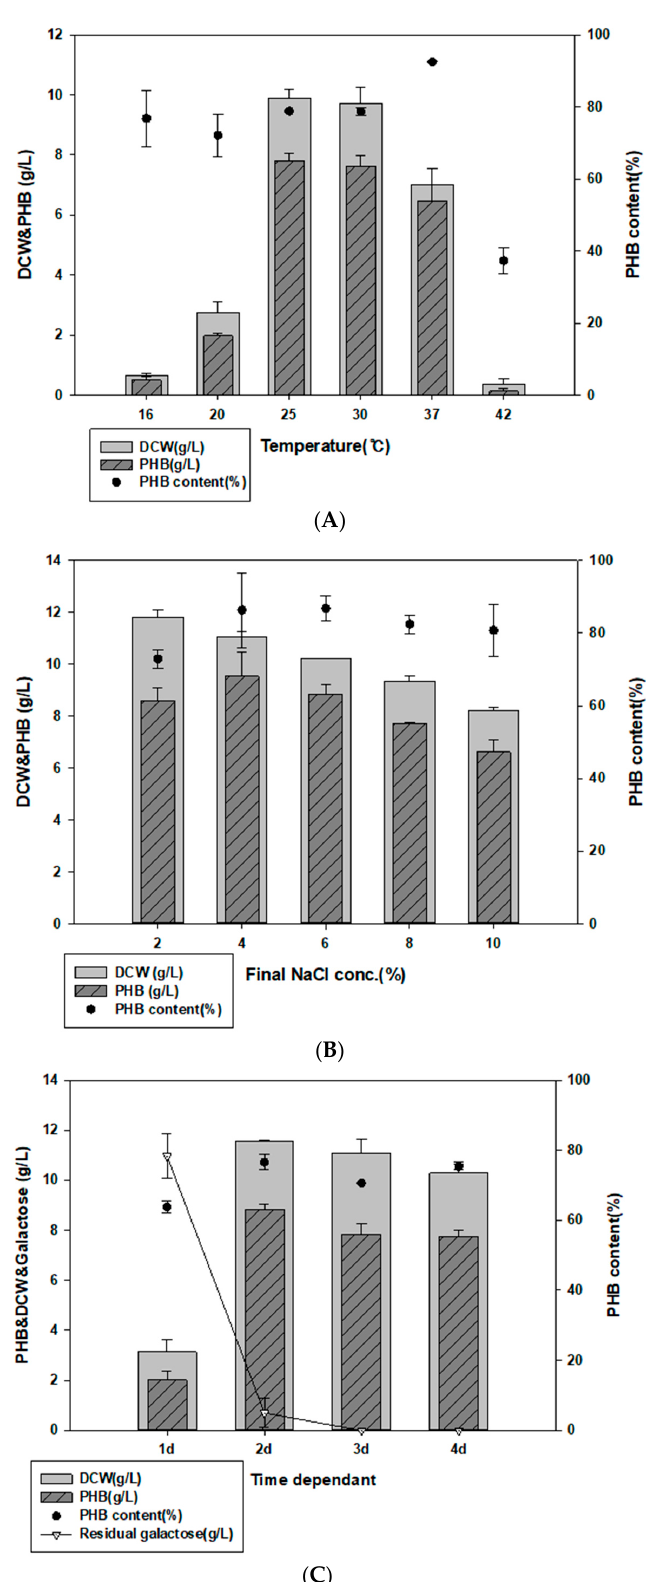
Figure 3. Optimized culture conditions for PHB production. ( A ) Effect of NaCl on PHB production in MB containing 2% ( w / v ) galactose. ( B ) Effect of temperature on PHB production in MB with 2% ( w / v ) galactose. ( C ) Optimized cultivation time for PHB production at 25 °C in MB with 2% galactose, final 4% NaCl, and 0.1% yeast extract.